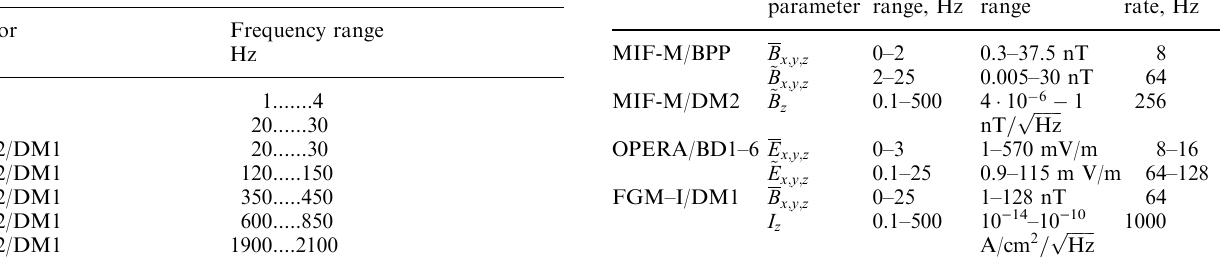
Table 4. ASPI parameters transmitted to the spacecraft telemetry system in the analogue form